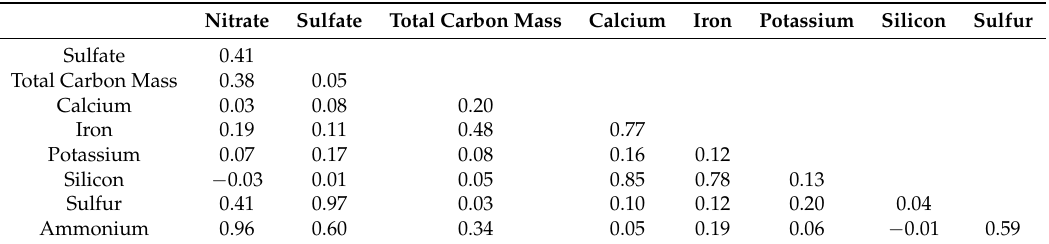
Table 2. Pearson correlation coefficients of weekly speciated pollutants from stations relevant to the study in the state of California,